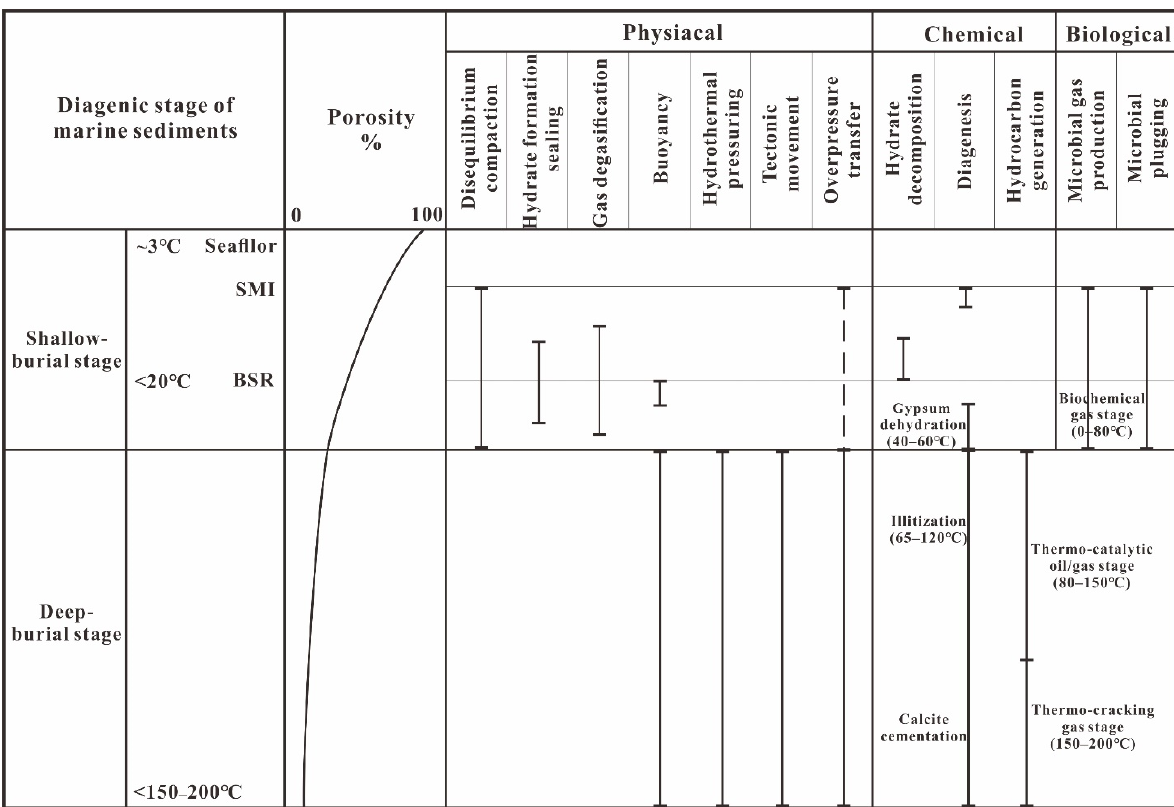
Figure 8. The appearance of each overpressure mechanism in the process after deposition of marine sediments. The solid lines indicate the most likely stage where overpressure appears, and the dotted lines indicate the stage where overpressure is likely to appear. SMI, sulphate methane interface; BSR, bottom-simulating reflector. Not to Scale.